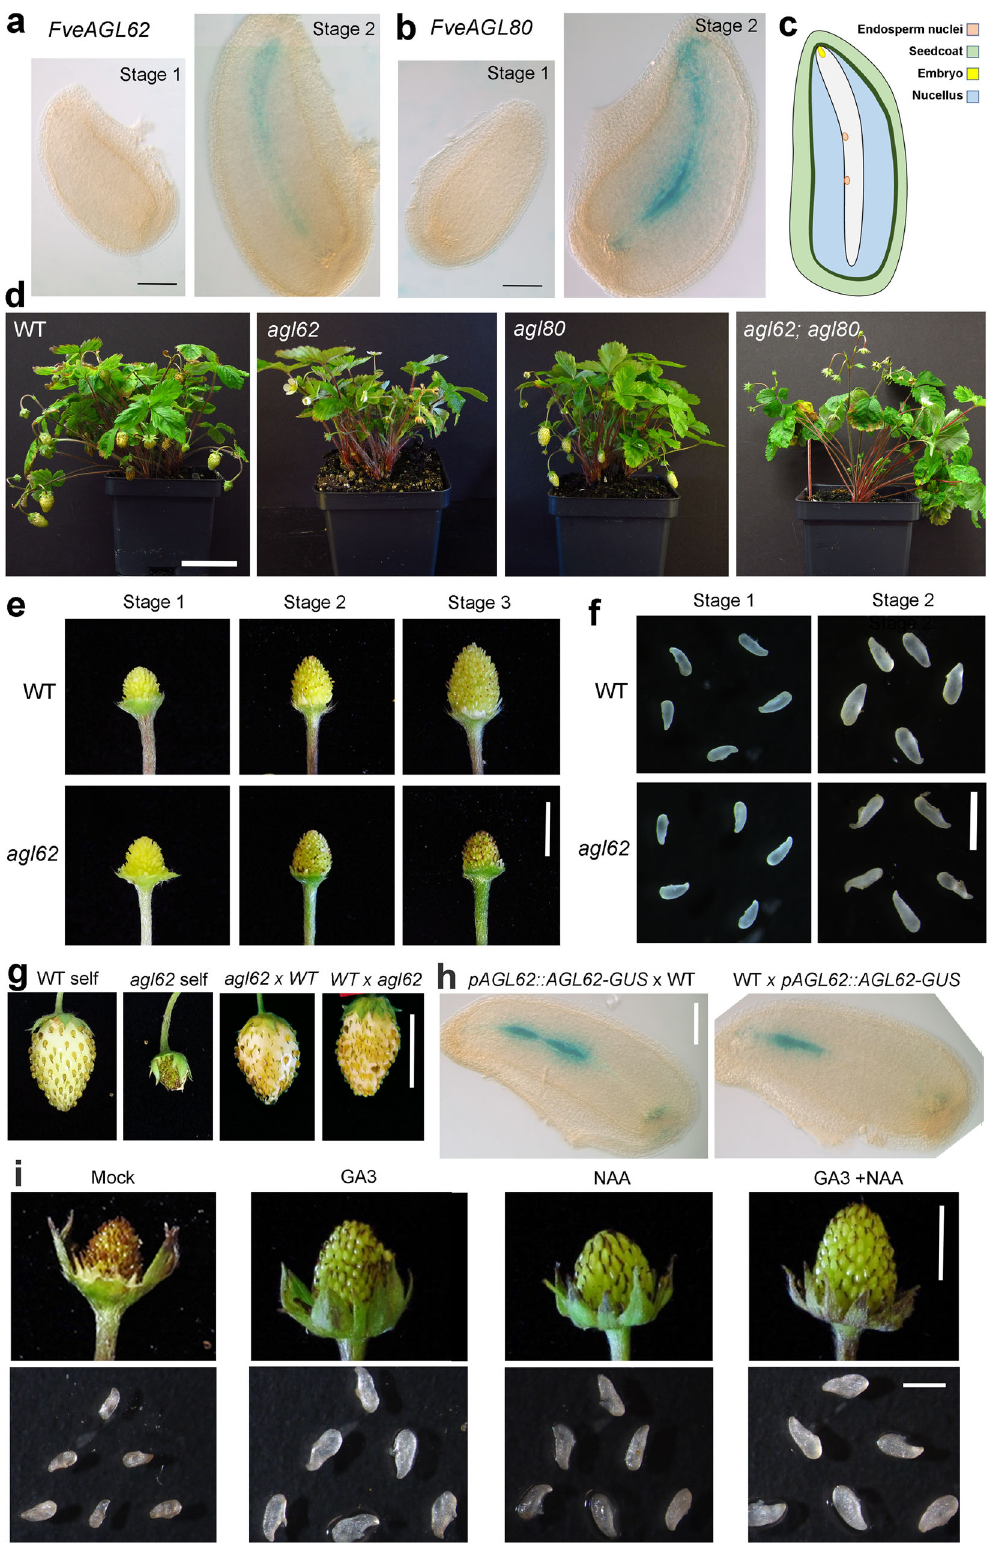
CRISPR/Cas9 was also used to generate a fveagl80 − 1/ − 1 mutant (Supplementary Fig. 2c), which exhibited normal vegetative growth and developed fruit similarly to wild type (Fig. 1d). Since FveAGL80 ( FvH4_6g08460 ) clusters together with four additional FveAGL80-Like ( FveAGL80L ) genes in F. vesca (Supplementary Fig. 1c), functional redundancy may have prevented any mutant